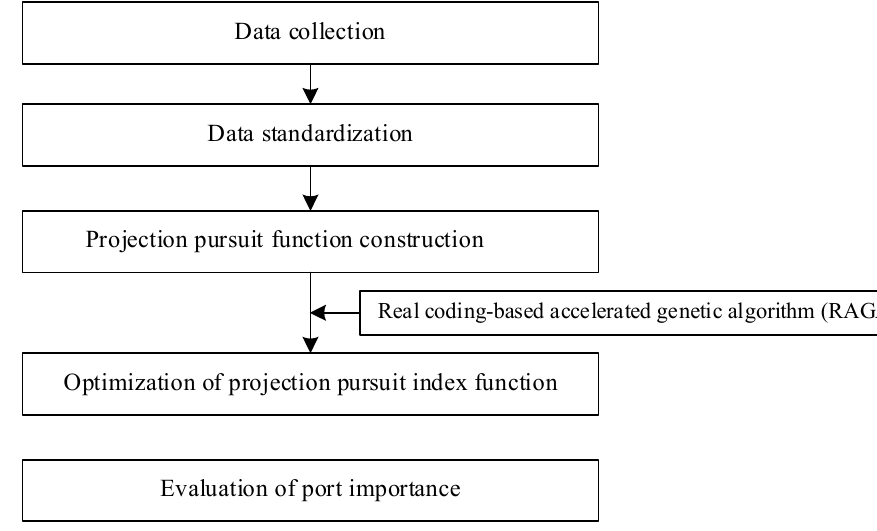
Figure 1. The flow path of projection pursuit model.